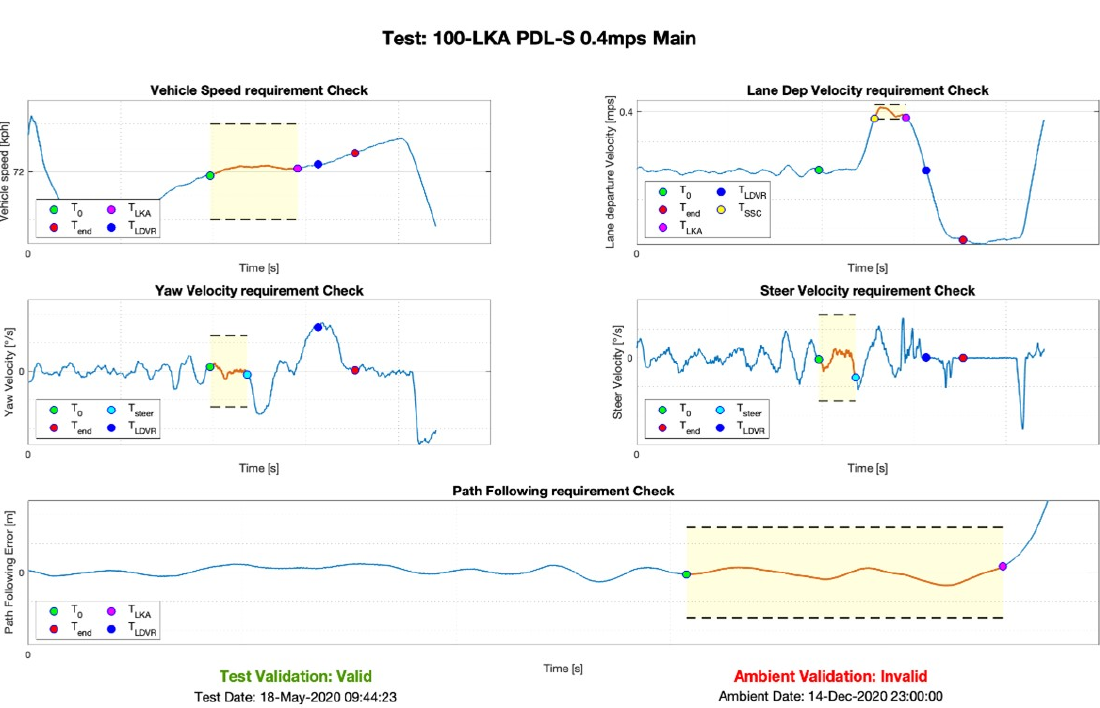
Figure 16. Post-processing results for a valid test LKA.